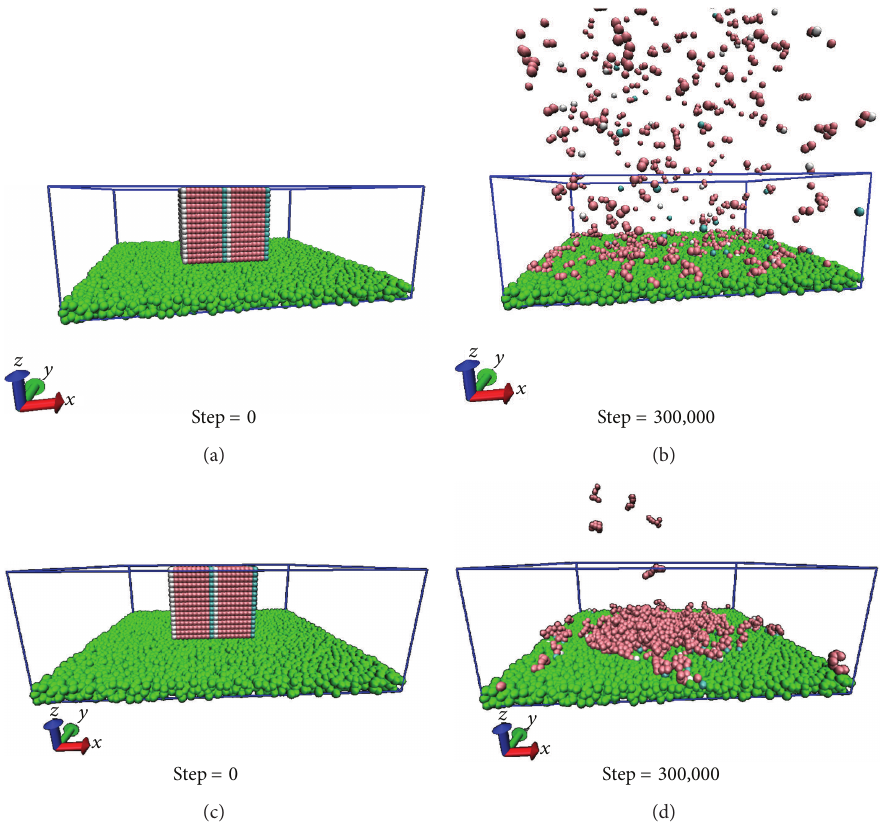
Figure 7: (a) Snapshots of PFPE Z at step 0; (b) snapshots of PFPE Z at step 300,000; (b) snapshots of PFPE Zdol at step 0; (d) snapshots of PFPE Zdol on a DLC substrate at step 300,000 when the DLC film is compressed into half of its original configuration at temperature 𝑇 ∗ = 7 (896 K = 623 ∘ C) with bond/break.